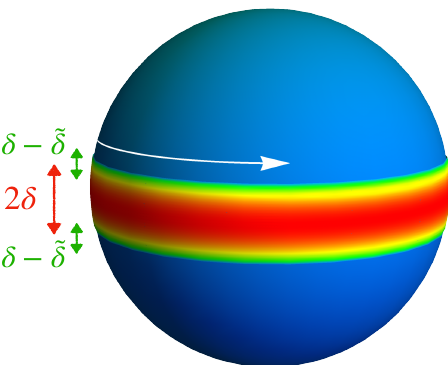
Figure 2 . In the blue region there are no low-lying excitations, the red region is the spinning superfluid and the green region is the boundary layer, which we discuss in subsection 4.4. As long as the red region is large enough, we can trust the giant vortex effective